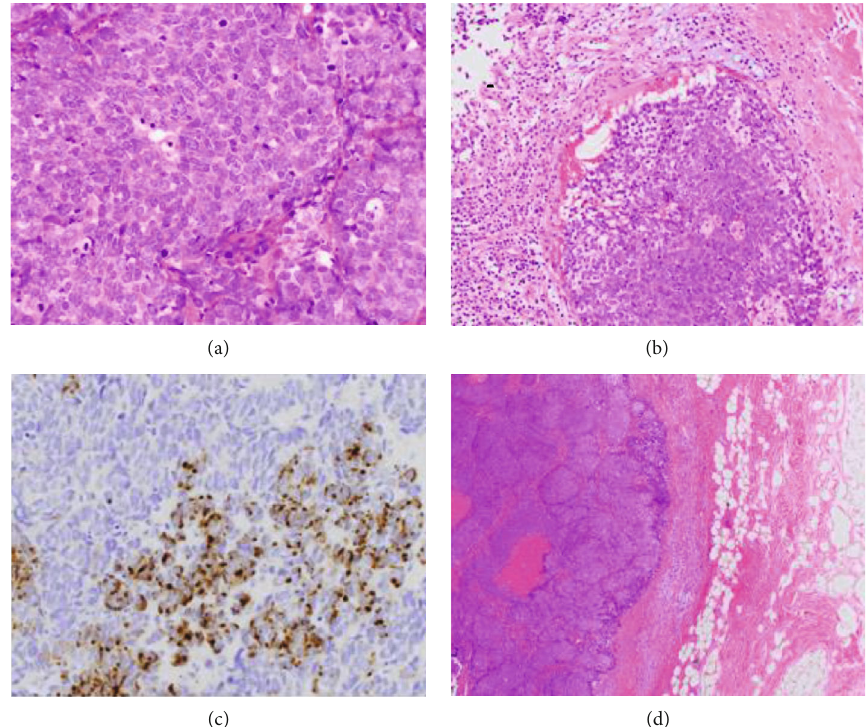
Figure 2: (a) Magni fi cation 400x, hematoxylin and eosin stain of the left neck; Merkel cell carcinoma primary tumor demonstrates numerous mitoses and neuroendocrine nuclei. (b) Magni fi cation 200x, MCC left neck primary highlighting lymphovascular invasion. (c) Magni fi cation 400x, immunohistochemistry demonstrates perinuclear dot-like immunostaining positive for cytokeratin 20. (d) Magni fi cation 40x, MCC primary tumor of the left neck in subcutaneous